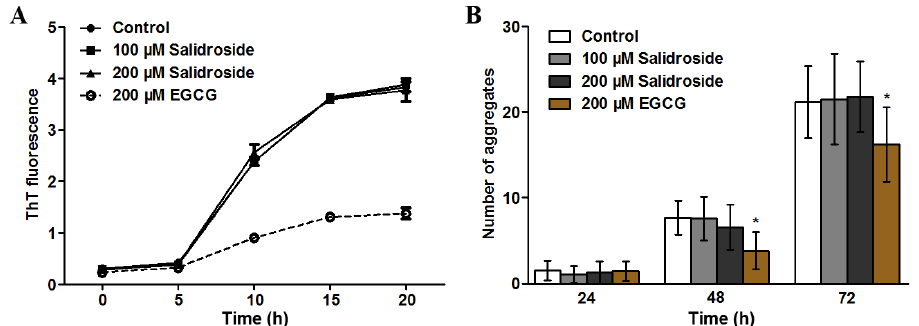
Figure 3. Effect of salidroside on polyQ aggregation. ( A ) Salidroside did not prevent in vitro polyQ aggregation. PolyQ40 was first incubated with salidroside or EGCG at 37 °C for indicated times and then mixed with ThT prior to fluorescence